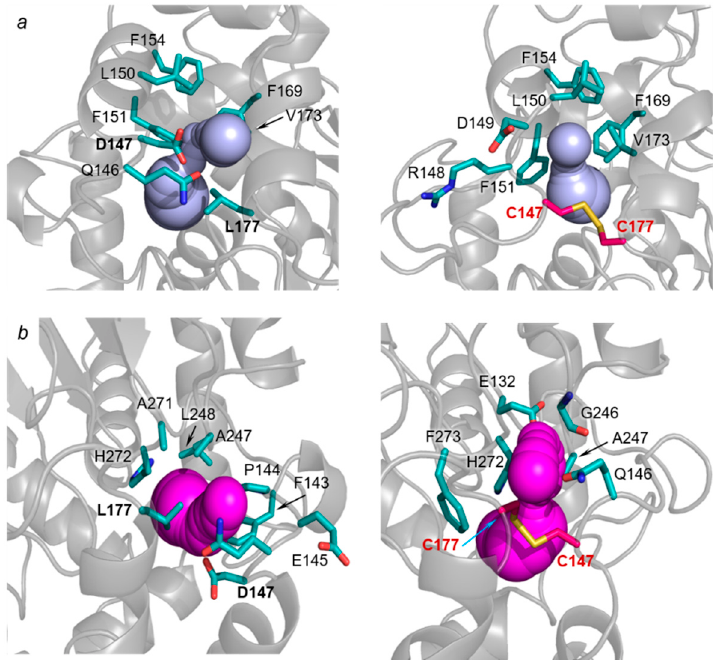
Figure 9. Close up view of ( a ) p1a and ( b ) p1b access tunnels in LinB WT (left, PDB ID: 2bfn, [18]) and LinB MD D147C+L177C (right). The tunnels are shown as blue (p1a) and magenta (p1b) spheres, the sidechains of bottleneck residues are shown as cyan sticks, the disulfide bridge is shown as red-yellow sticks.